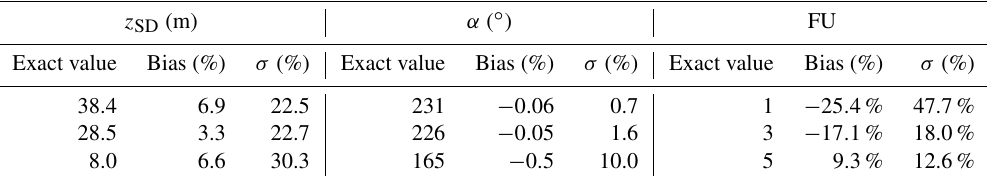
Figure 1. Monte Carlo simulation of error propagation from OC-CCI R rs to Secchi disk depth, hue angle and Forel–Ule index. Panels (a) – (c) show the results of 10000 simulations (black bars) for ultra-oligotrophic waters compared to the reference spectrum results (red line). Panels (d) – (f) show the results for an oligotrophic water spectrum, and (g–i) depict the results for a eutrophic water spectrum. Table 2. Biases and standard deviation ( σ ) of the errors caused by random additive Gaussian perturbations to three given remote-sensing reflectances from which the Secchi disk depth, the hue angle and the Forel–Ule index are derived. The “exact values” correspond to the red vertical lines in Fig.